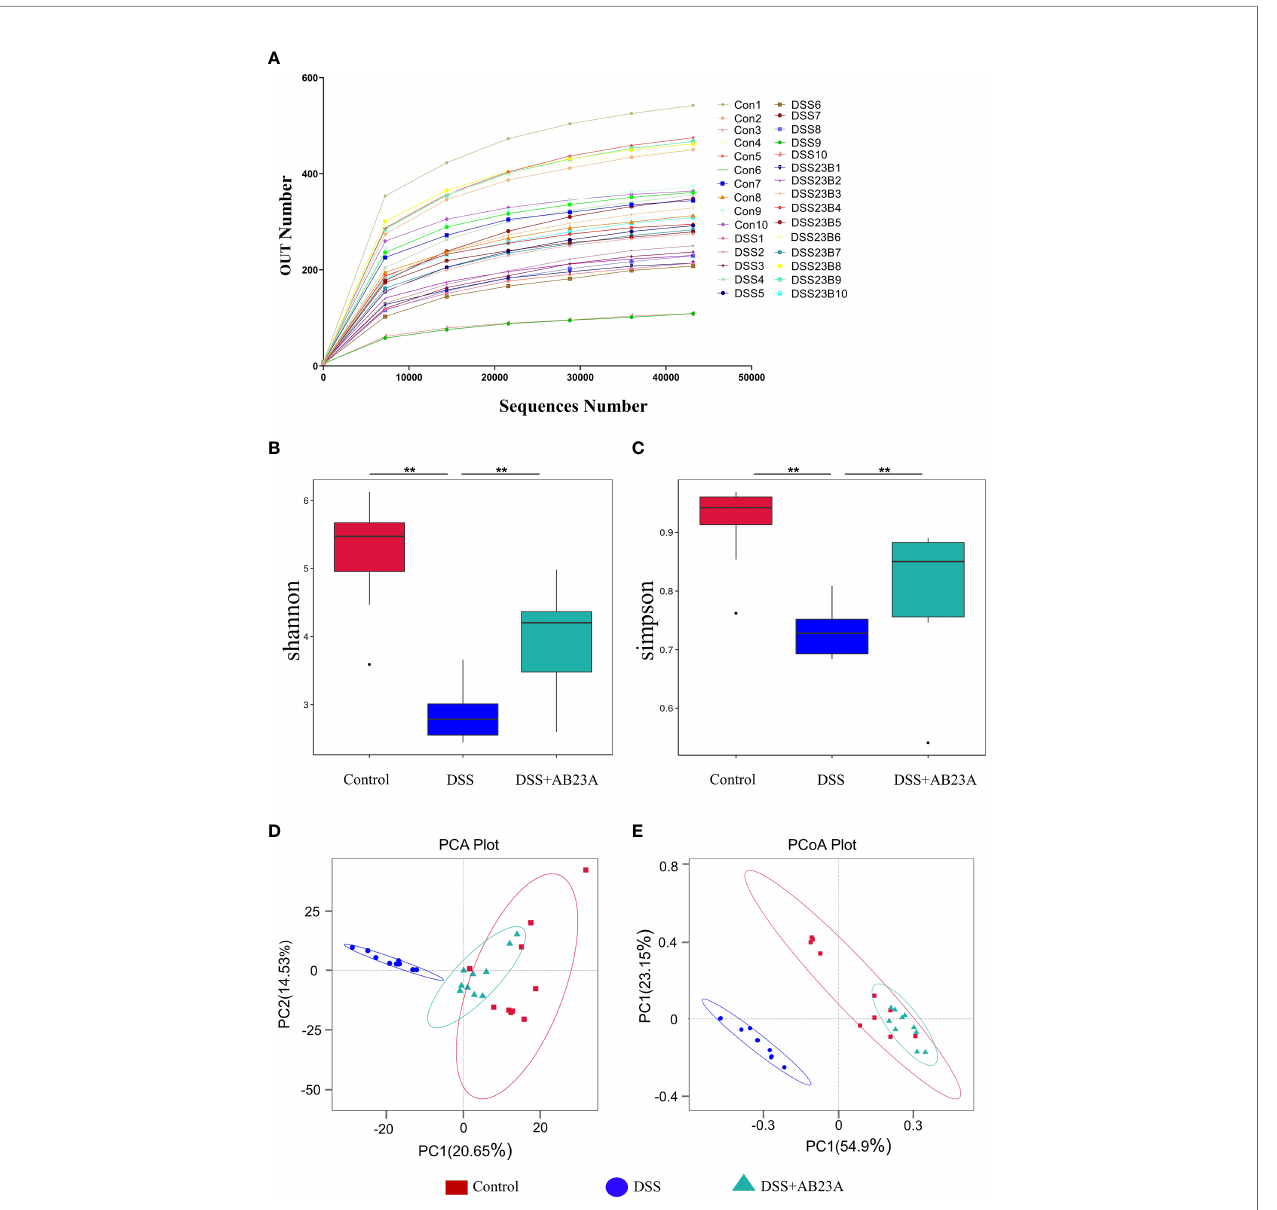
FIGURE 3 | Richness and diversity of fecal microbiotas among groups. (A) The rarefaction curve was used to measure sample rationality. (B, C) a -Diversity analysis: Shannon and Simpson box plots. (D) PCA of gut microbiota. (E) PCoA of gut microbiota (n = 10 samples per group. (vs. DSS: **P <